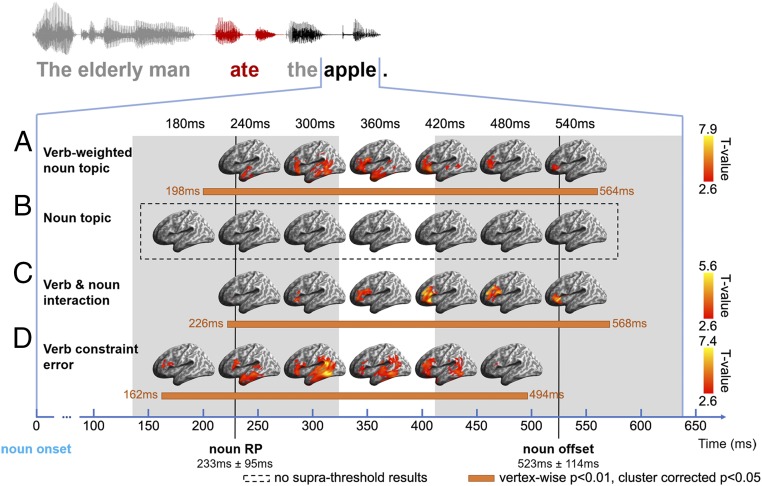
ssRSA results of model RDMs during the noun epoch (aligned to noun onset, extending forward by 640 ms to cover 1 SD of noun duration). (A) Verb-weighted noun topic RDM that captures noun semantics as modified by the prior verb. (B) Noun topic RDM that models the context-independent semantics of the DO noun. (C) Verb–noun interaction RDM reflecting the interaction between verb and noun semantics. (D) Verb constraint error RDM measuring the ease with which the DO noun fits into the semantic constraints placed by the prior verb. Significance was determined by 5,000 nonparametric permutations with vertex-wise P < 0.01 and cluster-wise P < 0.05. Horizontal orange bars indicate significant periods for different model RDMs. The gray shading indicates the range of 1 SD for noun RP and noun offset.